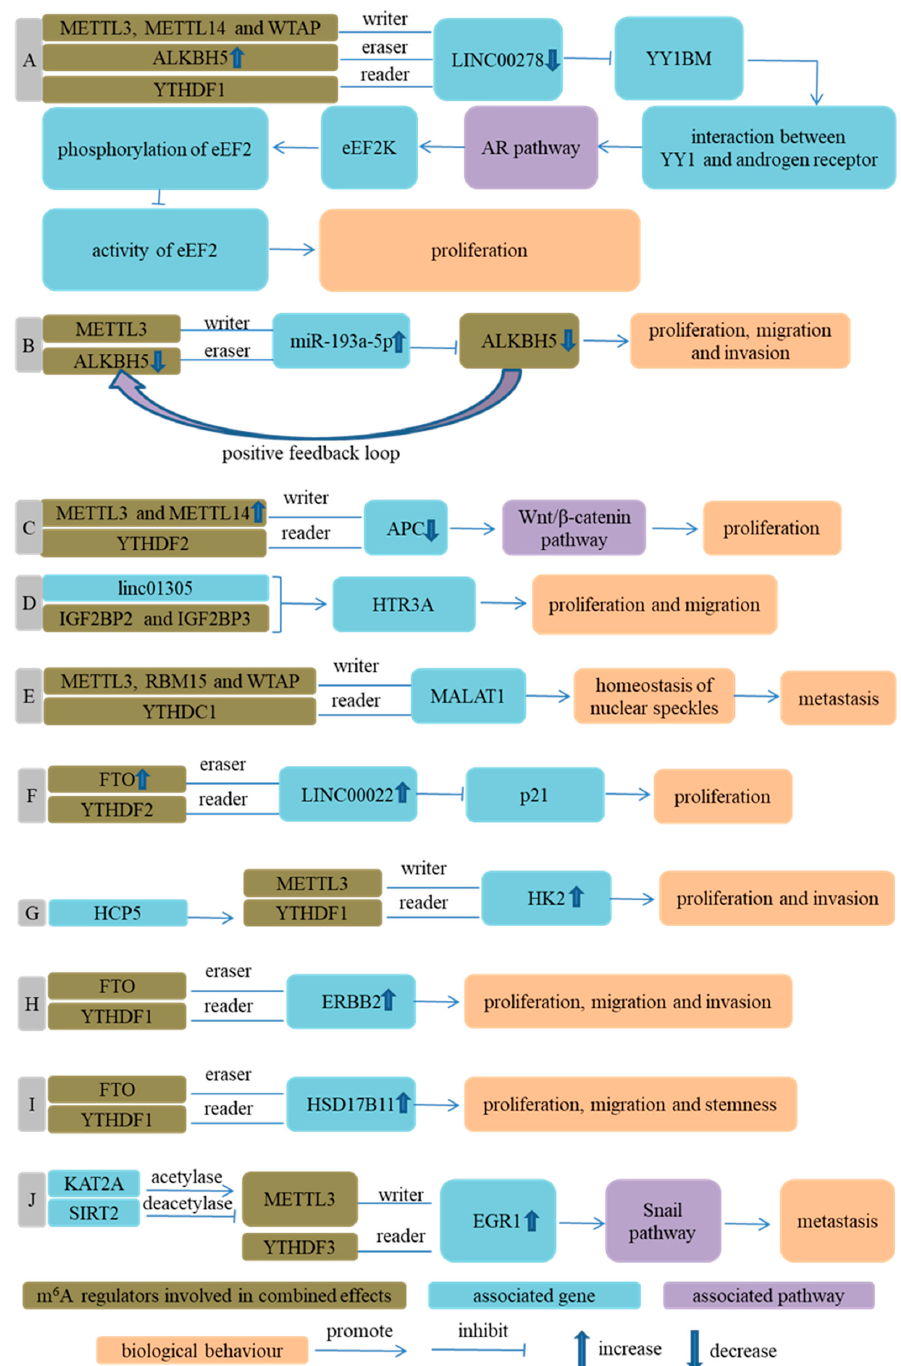
Figure 7. Combined effects of m 6 A regulators on ESCA progression. ( A ) Ref. [81] Cigarette smoking enhanced ALKBH5 expression through decreasing methylation of ALKBH5 promoter, downregulated m 6 A modification of LINC00278 and binding of YTHDF1 with LINC00278 and consequently led to translation suppression of Yin Yang 1 (YY1)-binding micropeptide (YY1BM), a micropeptide encoded by LINC00278. Downregulation of YY1BM promoted the interaction of YY1 with androgen receptor (AR), activated AR signaling pathway and increased eEF2K expression. Under nutrient deprivation, the elevated phosphorylation of eEF2 inhibited activity of eEF2 and translation elongation and increased survival of ESCC cells; ( B ) Ref. [80] miR-193a-3p could target ALKBH5 and inhibit expression of ALKBH5. Interestingly, knockdown of ALKBH5 promoted the maturation of